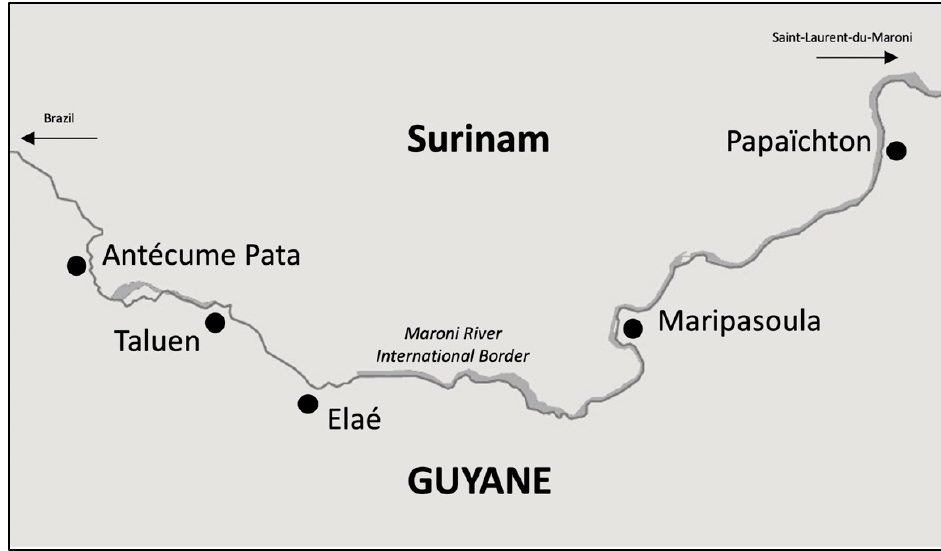
Figure 2. The Region of Maripasoula/Haut-Maroni.